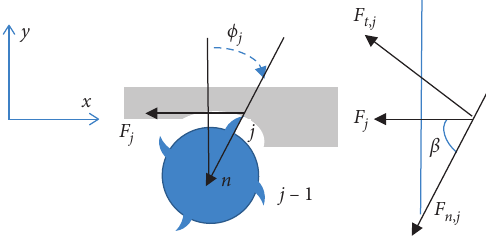
Figure 3: Dynamic milling